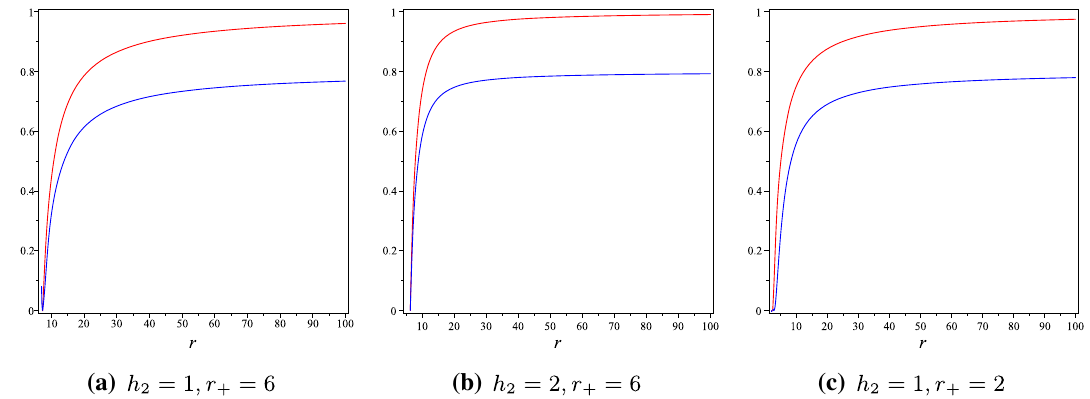
Fig. 12 The behavior of f ( r ) (blue line) and 0 . 8 h ( r ) (red line) in terms of r for c 1 = α = − 0 . 5. Left: correspond to the red branch. Middle: correspond to the blue branch. Right: correspond to the yellow branch in Fig.